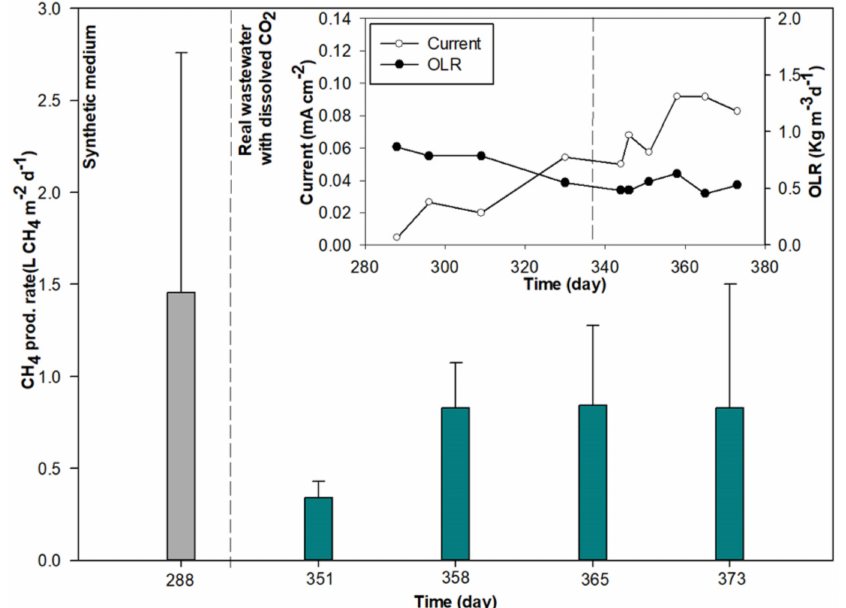
Figure 7. CH 4 production rate of individual EMG-BES (BES 5), operated at constant voltage of 0.7 V, when passing from synthetic to municipal wastewater feeding. Sub-figure represents current density consumption and applied organic loading rate (OLR) during the same experimental period. Reference vertical lines identify the moment when synthetic feeding was replaced by real wastewater